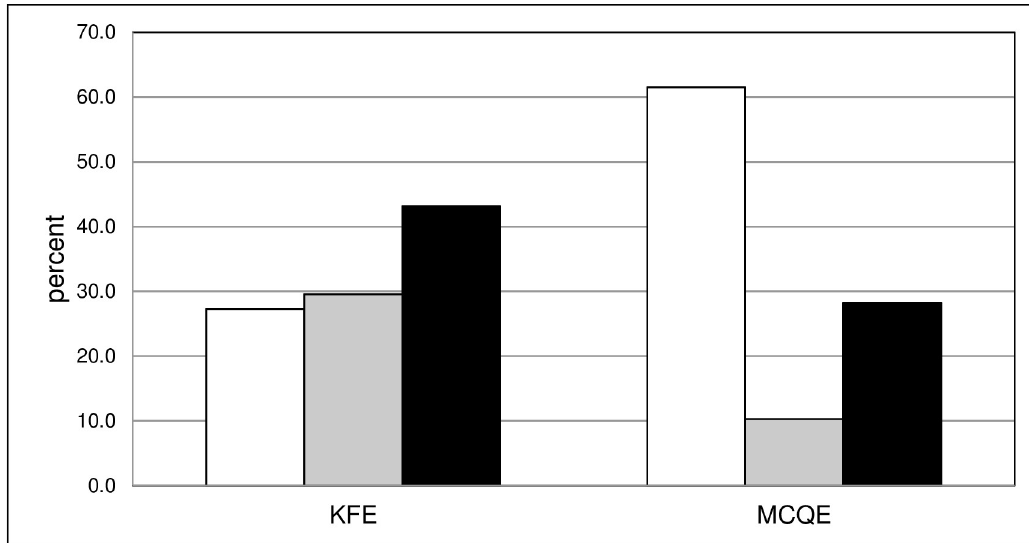
Fig 2. Modified Bloom’s categorization for KFPE and MCQE questions. White column: Modified Bloom’s Level 1; Grey column: Modified Bloom’s Level 2; Black column: Modified Bloom’s Level 3.